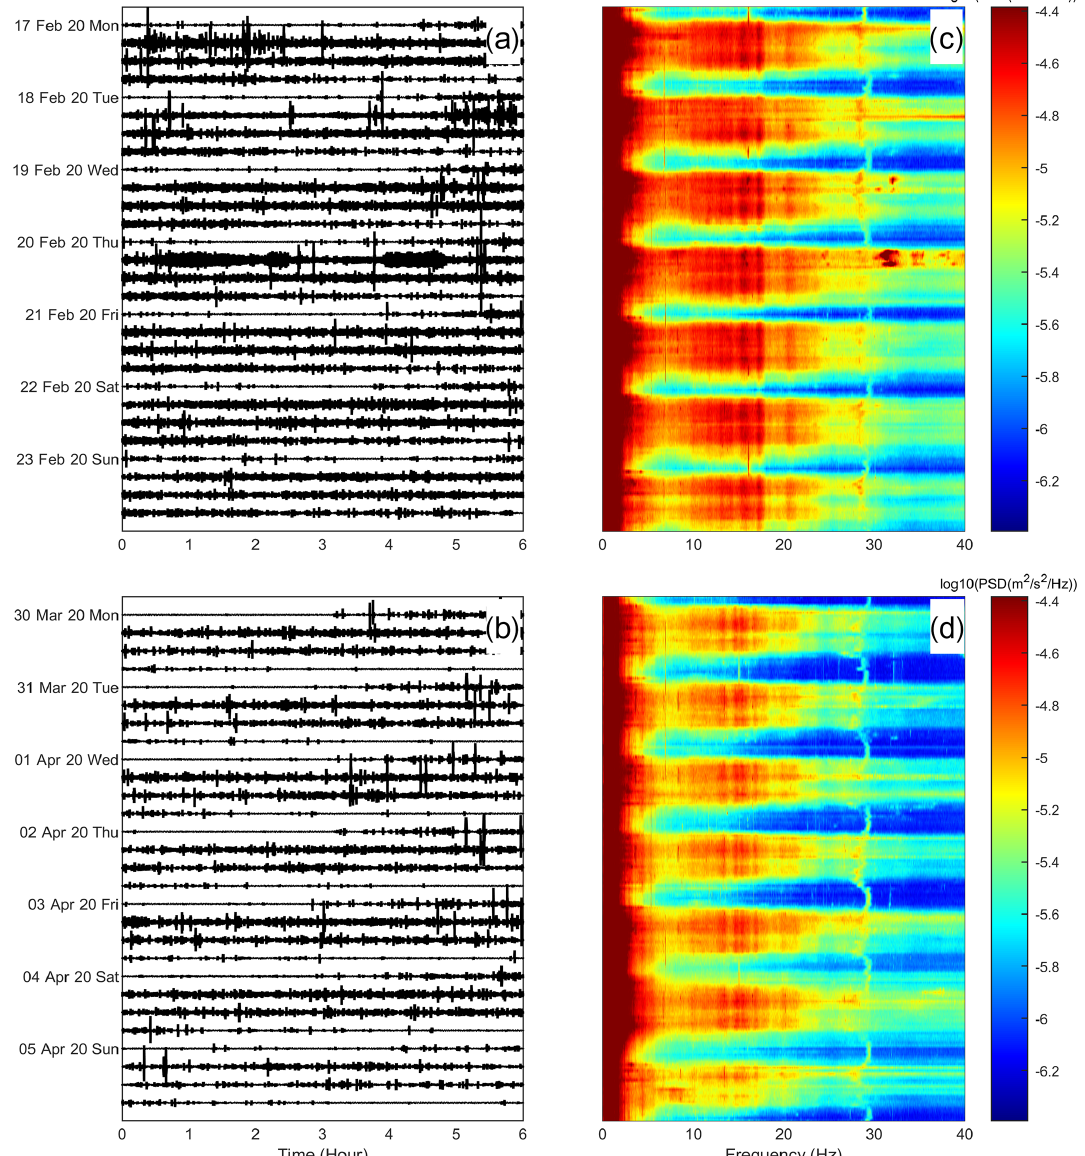
Figure A4. (a) Seismogram showing the seismic signal recorded by the vertical component of the station EFIU and filtered in the band 10–40Hz during the week 17–23 February 2020 and (c) the corresponding spectrogram of the non-filtered signal. (b) Seismogram showing the seismic signal recorded by the vertical component of the station EFIU and filtered in the band 10–40Hz during the week 30 March– 5 April 2020 and (d) the corresponding spectrogram of the non-filtered signal.